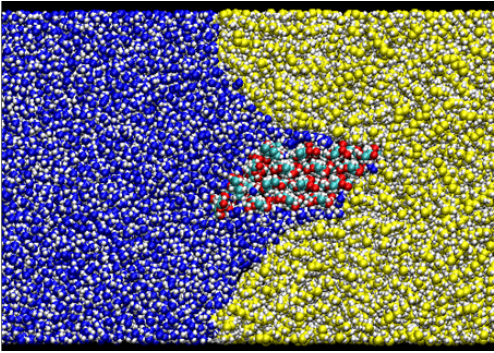
Figure 9. An example of largely deformed water–oil interface; cross-sectional snapshot for ( x = 10.0Å, θ z = 45 ◦ )